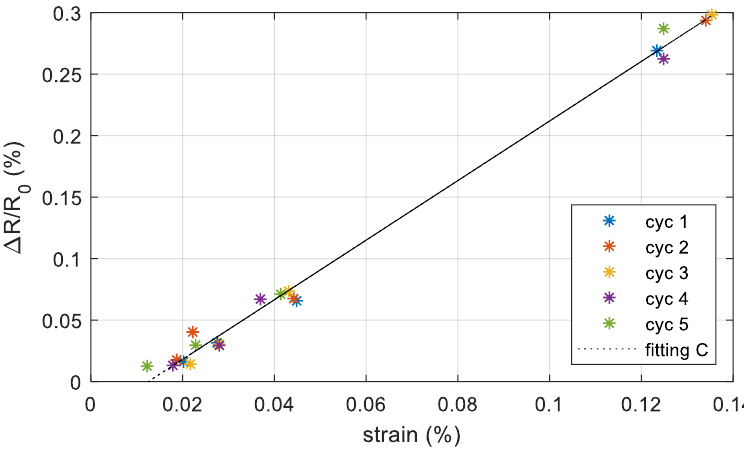
Figure 12. Resistance change with respect to the starting resistance (no external loads) versus the measured strain in the area including the sensor under cyclic loading. The points are the measurements data for each cycle (loading-unloading) while the dashed line is the best-fit line using the least square method.